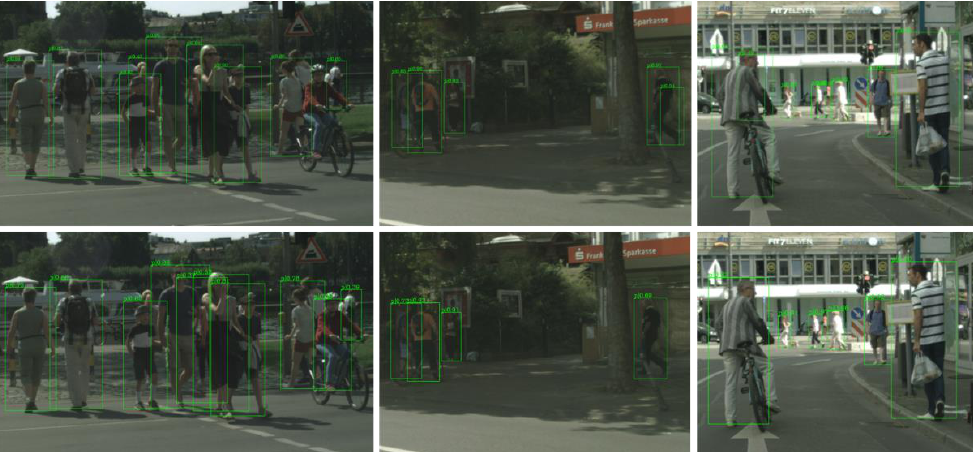
Figure 6. Qualitative results from the baseline method ( the first row ) and our RPDet+ALR ( the second row ) in the CityPersons validation set.